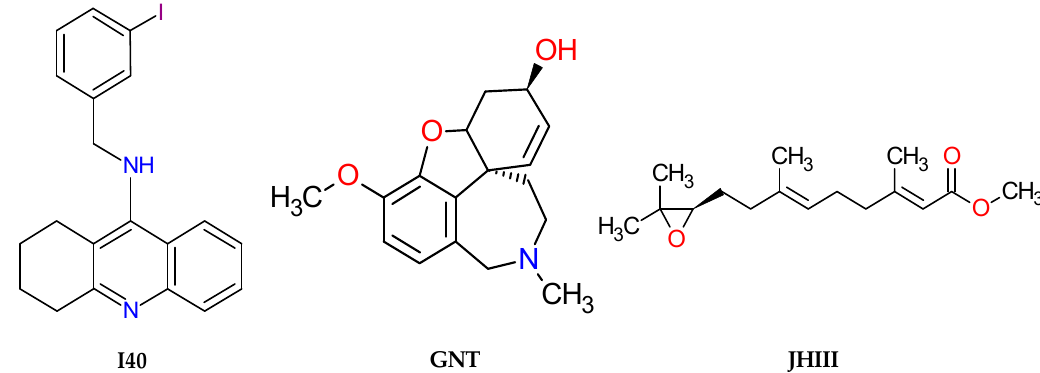
Figure 11. Structures of the AChE inhibitors, 9-(3-iodobenzylamino)-1,2,3,4-tetrahydroacridine (I40), ( − )-galanthamine (GNT) and methyl(2E,6E)-9-[(2R)-3,3-dimethyloxiran-2-yl]-3,7-dimethylnona-2,6-dienoate (JHIII), used in the present work.